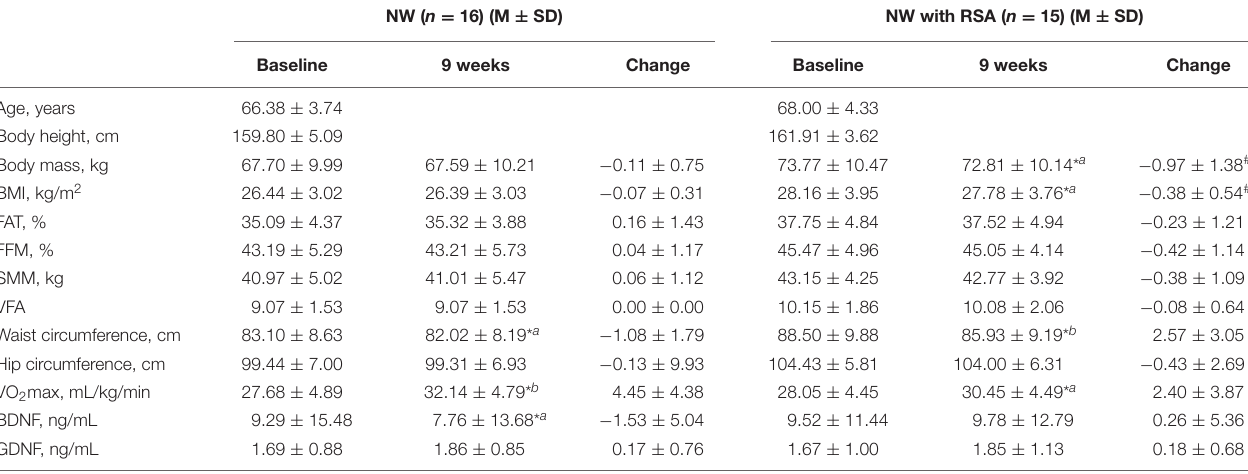
TABLE 1 | Somatic characteristics, cardiopulmonary efficiency, and biochemical indices of women subjected to an 8-week NW and NW with RSA training program.